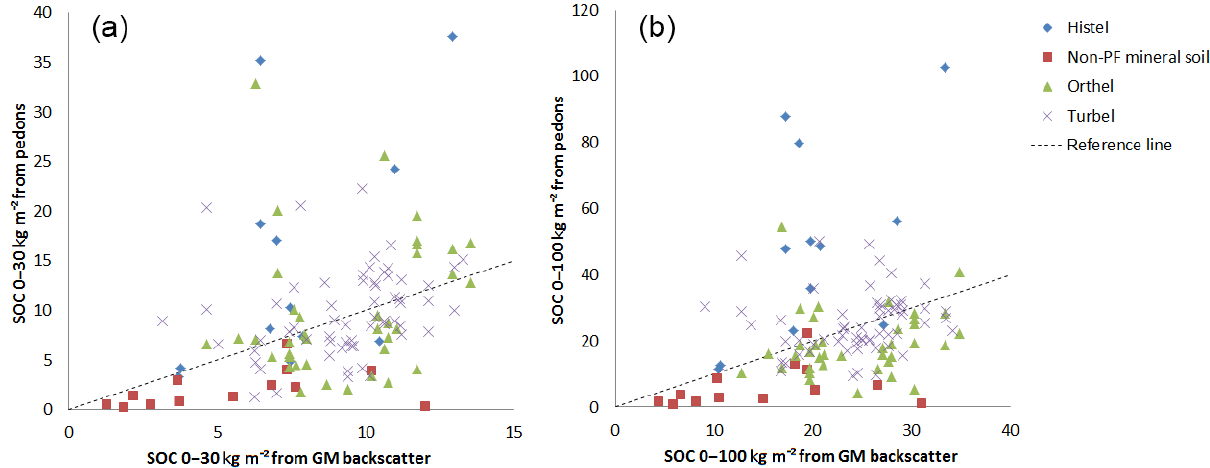
Figure 13. SOC 0–30 (left) and 0–100cm (right) results from ENVISAT ASAR GM in comparison to pedon (point) measurements from Kytalyk, Zackenberg, Shalaurovo, Arymas and Tulemalu by soil type.